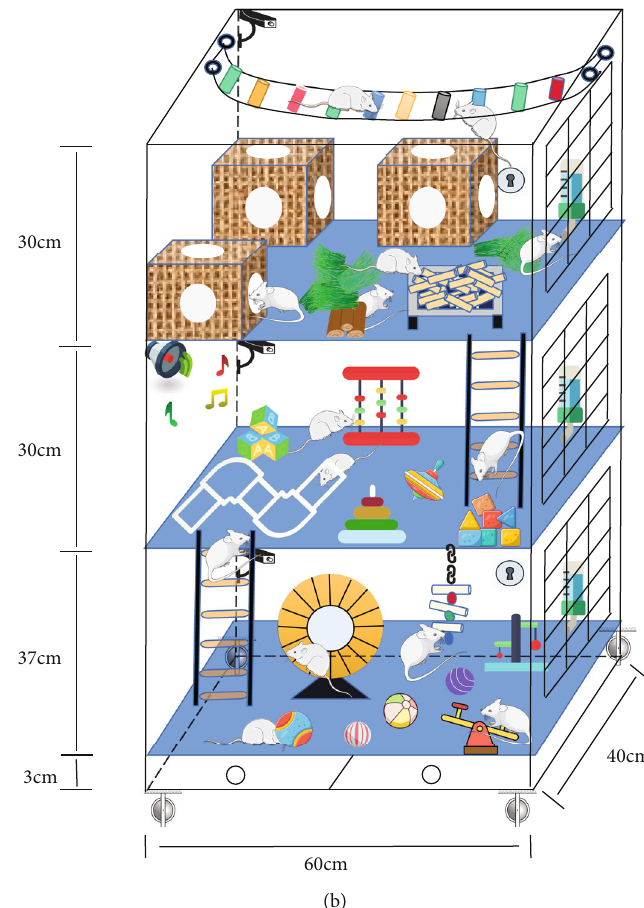
Figure 1: (a) A classic rodent ’ s enriched environment paradigm. There is a larger space in the EE cages to place more animals (8 – 14 per cage) and various toys, shelters, and other objects to increase sensorimotor stimulation, and the types and positions of objects in the cage are regularly changed to encourage spontaneous exploration. (b) An improved rodent ’ s enriched environment paradigm. The cage is divided into three layers according to the mechanistic routes of EE. In the fi rst layer, voluntary running wheels, climbing ropes, balls, and other objects are placed in the room to enhance locomotion and physical activity. In the second layer, various colored building blocks, toys, and music are used to increase sensory stimuli. In the third layer, shelters, nesting materials, and climbing ladders are placed to increase social interaction and exploratory activities. The objects in EE cage are in line with rodents ’ habits and nonstressful. Each layer is equipped with a monitor to record the animal ’ s behavior track, and the running wheel is equipped with a sensor to detect the animal ’ s movement. The ladder connecting each fl oor is easy to